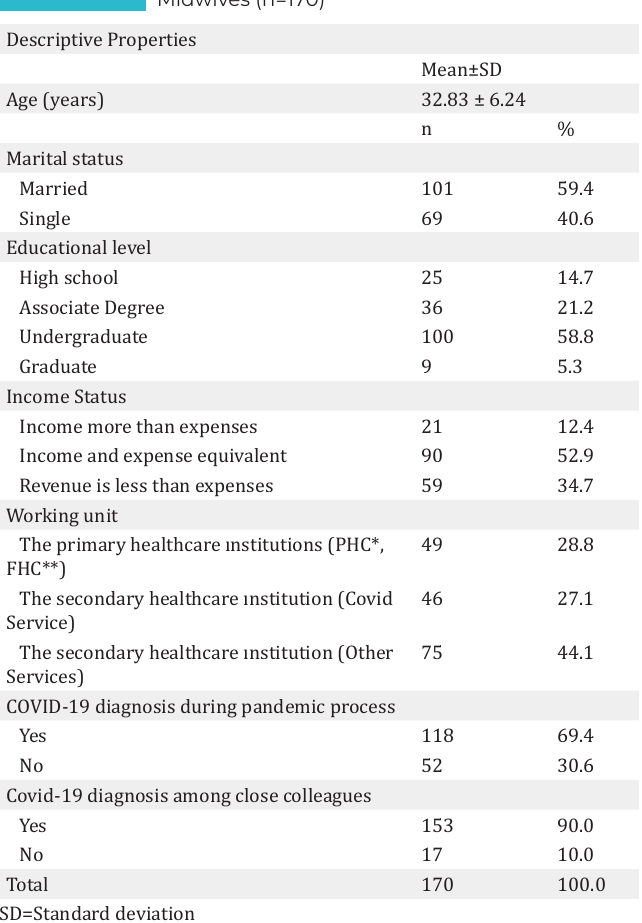
Comparison of Average Scores that Midwives and Close Colleagues Get from Secondary Traumatic Stress Scale (STSS) Total and Subdimensions according to Being Diagnosed with Covid-19 (n=170)